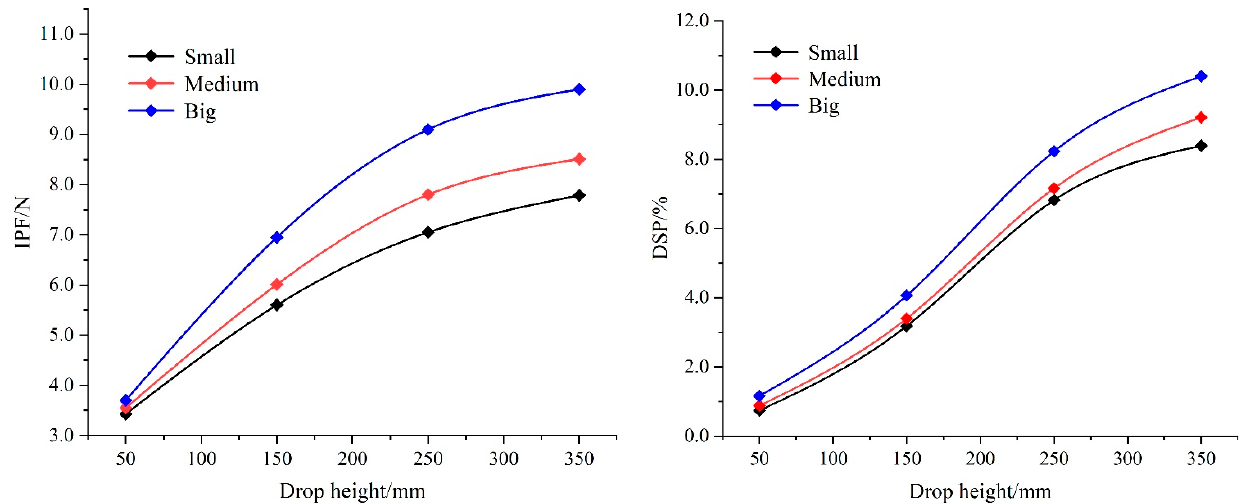
Figure 9. Effect of seedling pot size and drop heights on IPF and DSP.